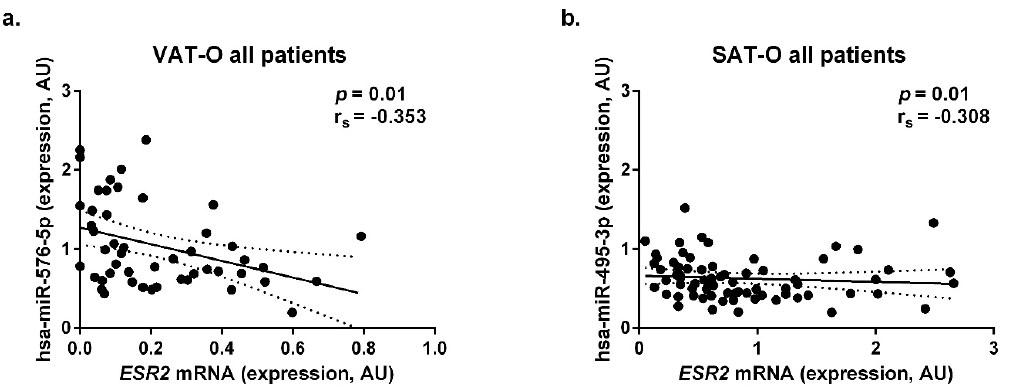
Figure 6. Correlations of ESR2 mRNA concentrations with hsa-miR-576-5p ( a ) levels in the visceral adipose tissue (VAT) and with hsa-miR-495-3p levels ( b ) in the subcutaneous adipose tissue (SAT) of all obese (O) study participants. AU—arbitrary units.